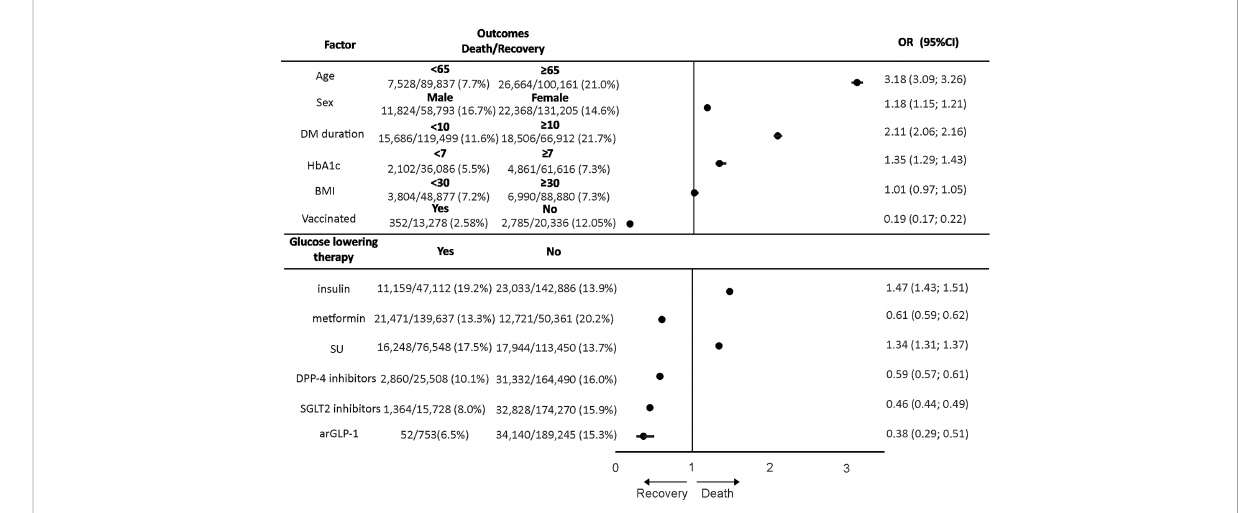
FIGURE 3 The analysis for association [odds ratio (OR)] between demographic and clinical characteristics, glucose-lowering therapy, and coronavirus disease 2019 (COVID-19) case fatality rate (recovery or death outcomes) in patients with type 2 diabetes mellitus